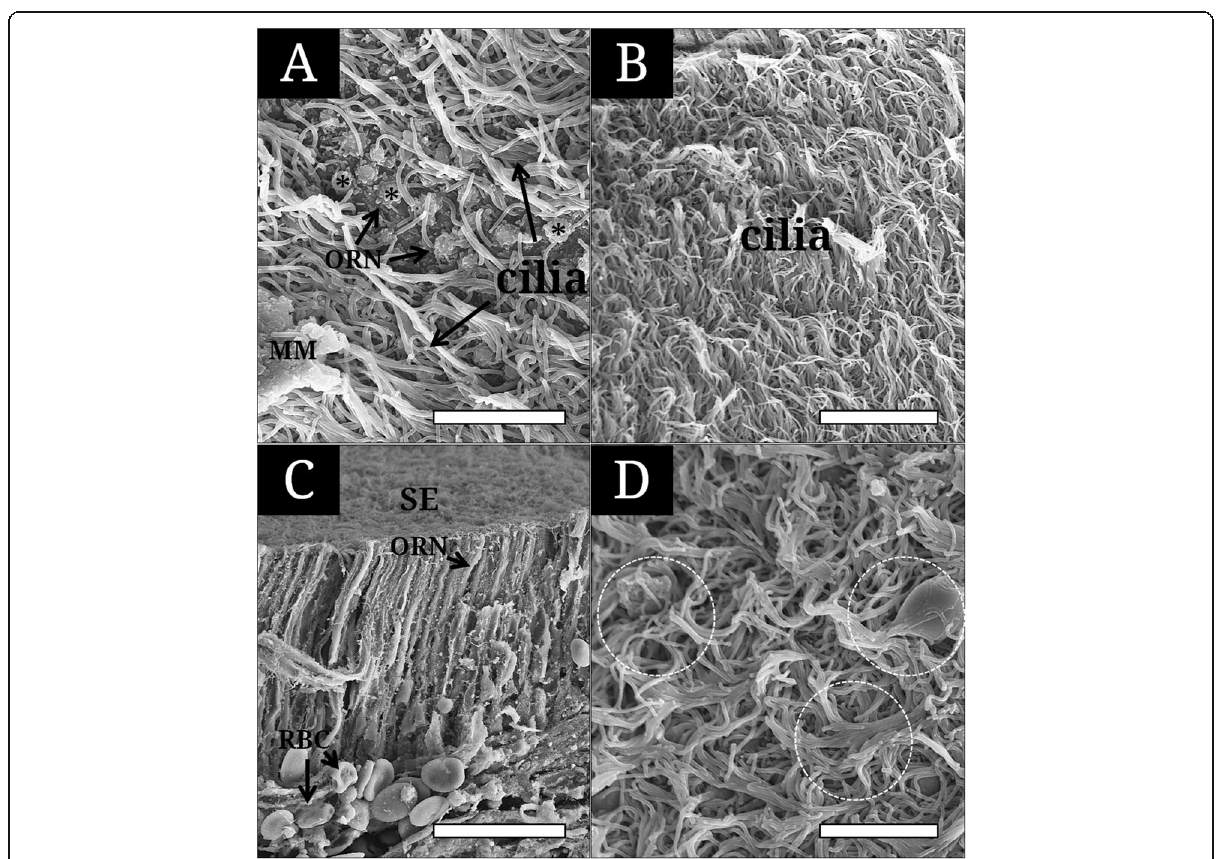
Fig. 4 Scanning electron micrographs showing the surface and cross section of the sensory epithelium of Lethenteron reissneri . a , the sensory epithelium with olfactory receptor neurons, long cilia of the supporting cell and mucous mass; b , long cilia covering the sensory surface; c , the cross section showing olfactory receptor neurons extending to the surface; d , long cilia getting intertwisted and gathered with mucous mass. Asterisk, the ciliated ORN ’ s knob; broken circle, gathered cilia; MM, mucous mass; ORN, olfactory receptor neuron; RBC, blood cell; SE, sensory epithelium. The bars indicate 5 μ m in a, b, d and 30 μ m in c ,